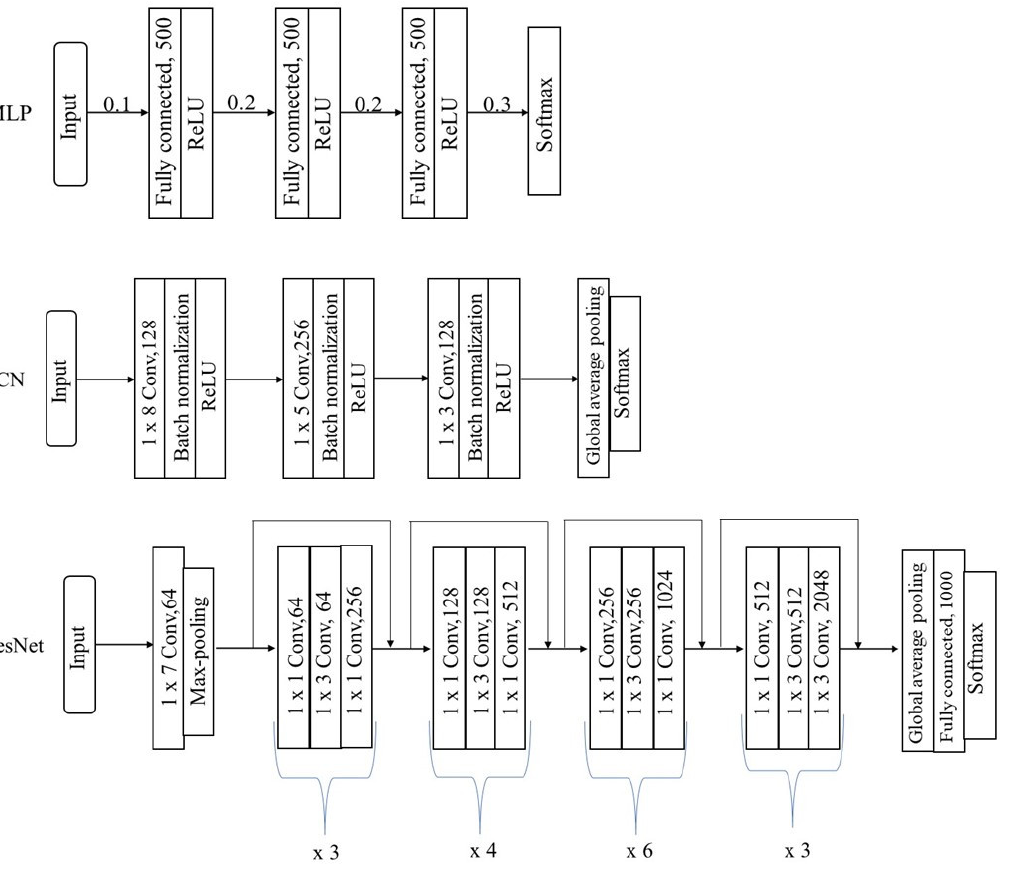
Figure 5. The architecture of three SOTA DNNs: ( a ) MLP; ( b ) FCN; ( c ) ResNet 50.